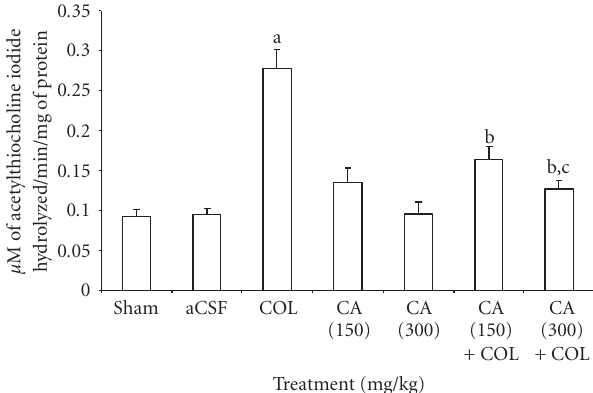
Figure 2: Centella asiatica (CA; 150 and 300 mg/kg, PO) on acetyl cholinesterase activity in Intracerebroventricular colchicines- (COL-) treated rats. Values are mean ± SEM; a P < . 05 as compared to artificial cerebrospinal fluid- (aCSF-) injected group; b P < . 05 as compared to colchicine treated group; c P < . 05 as compared to CA (150) + COL group; (one-way ANOVA followed by Turkey’s test for multiple comparisons). Note: aCSF: artificial